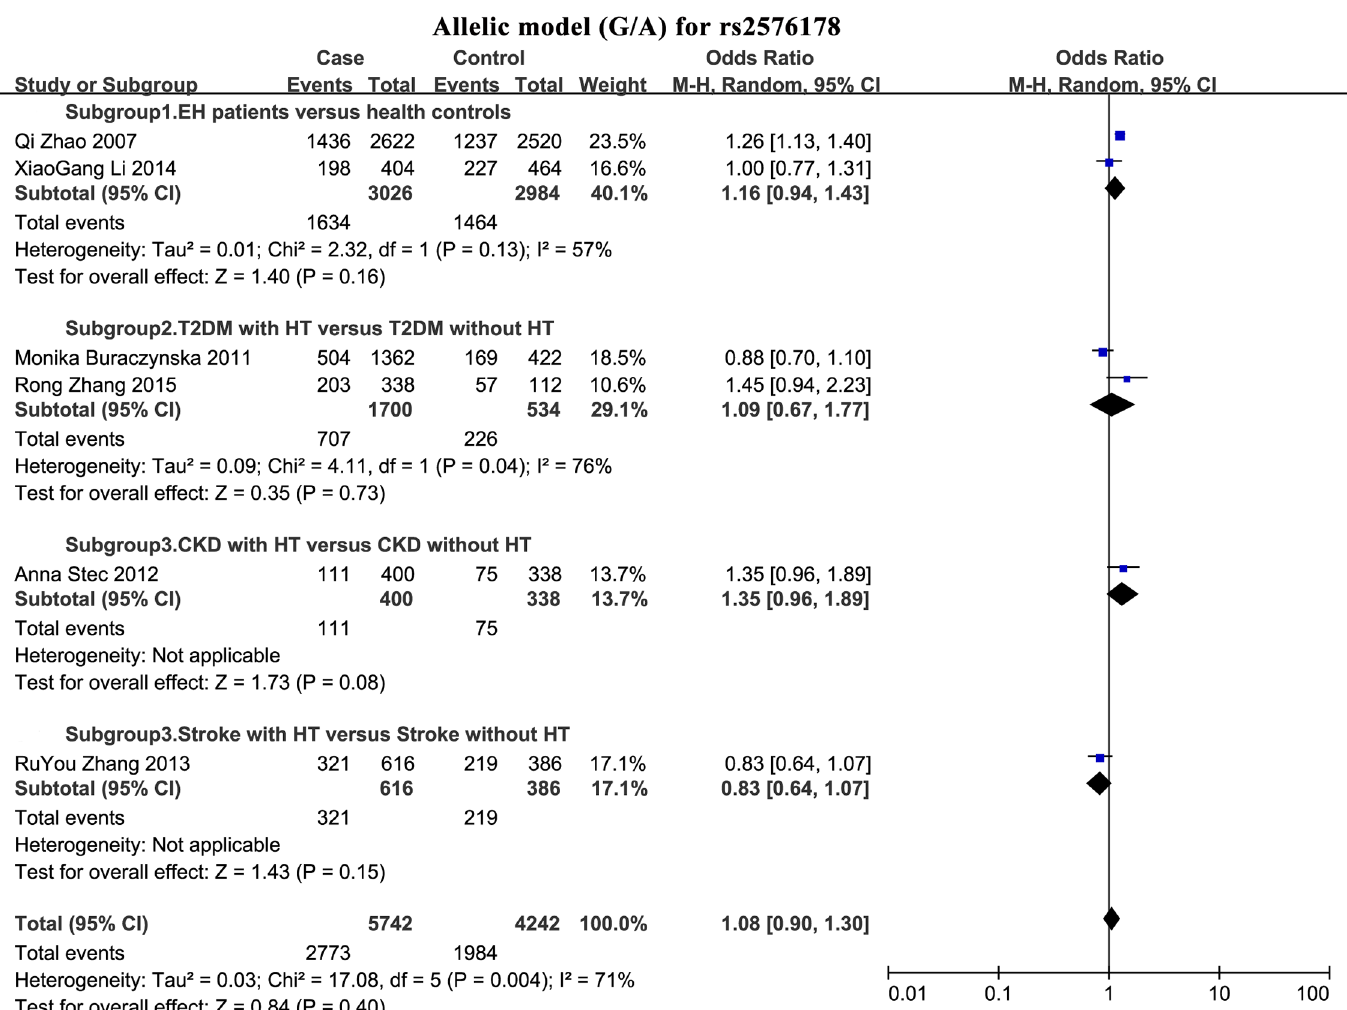
Fig 4. Forest plot of the association between rs2576178 and risk of HT in the allelic model (G/A). Case events indicate hypertensive subjects; Control events indicate normotensive subjects.